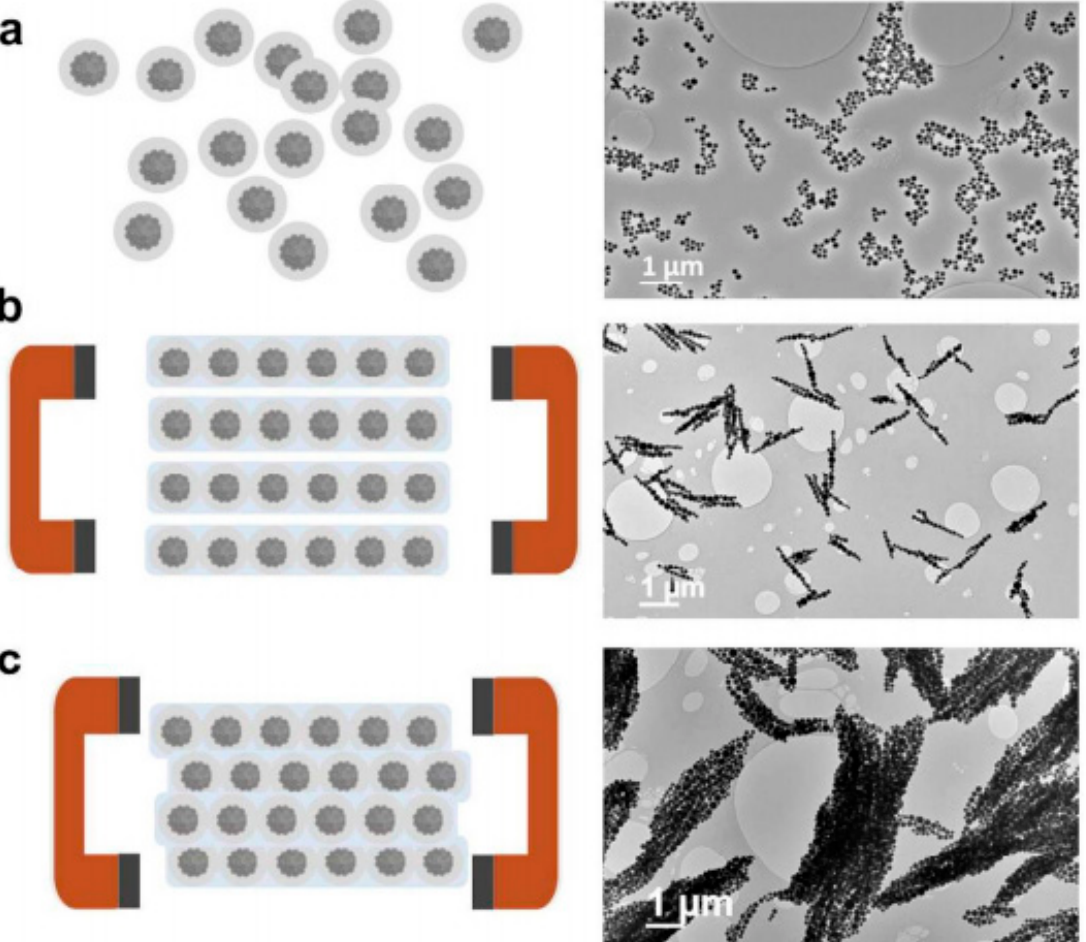
Figure 9. Schematic representation of the fabrication process (left-hand image) and the corresponding transmission electron microscopy images (right-hand image) of ( a ) silica-coated superparamagnetic nanoparticle clusters, ( b ) nanochains, and ( c ) nanobundles (reprinted with permission from [177]. Copyright 2015 American Chemical Society).